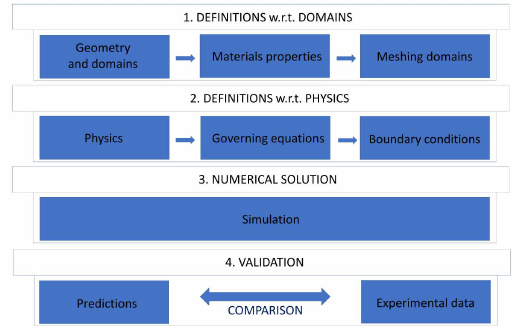
Figure 8. Electrochemical-thermal modelling